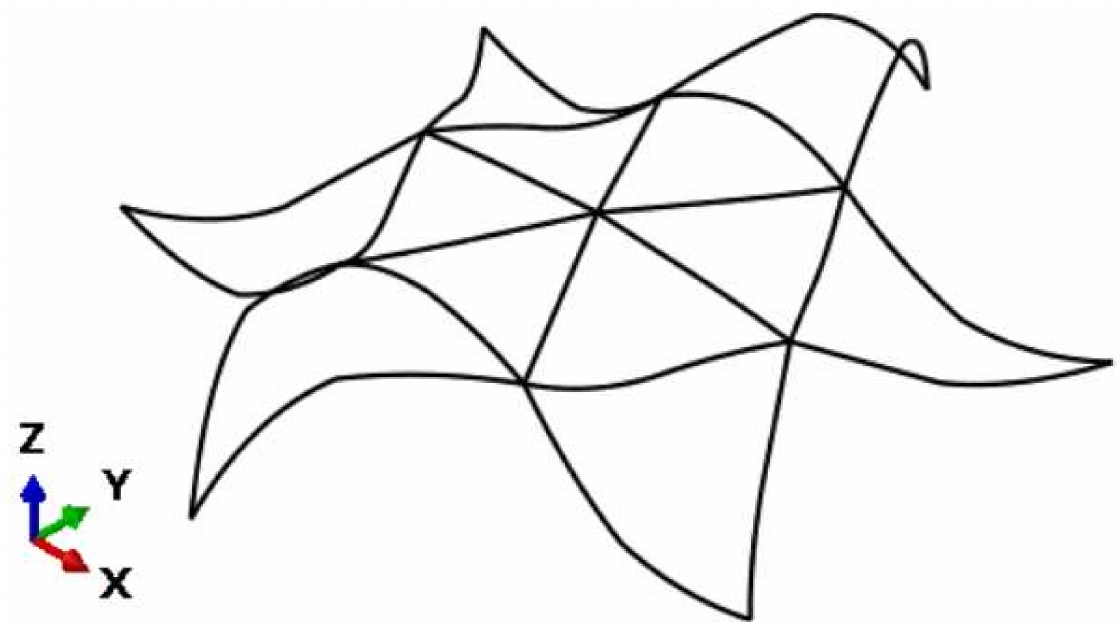
Figure 9. Dome 2—imaginary part of the second nonlinear eigenvector (values multiplied by